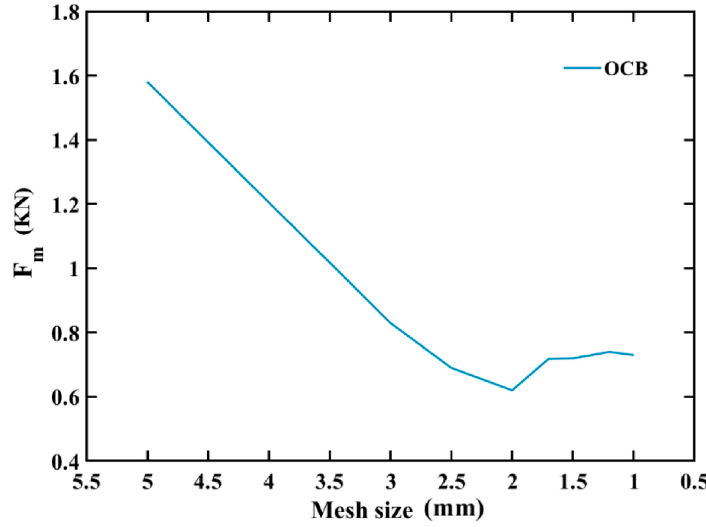
Figure 5. Influence of mesh size on average peak force for finite element simulation.